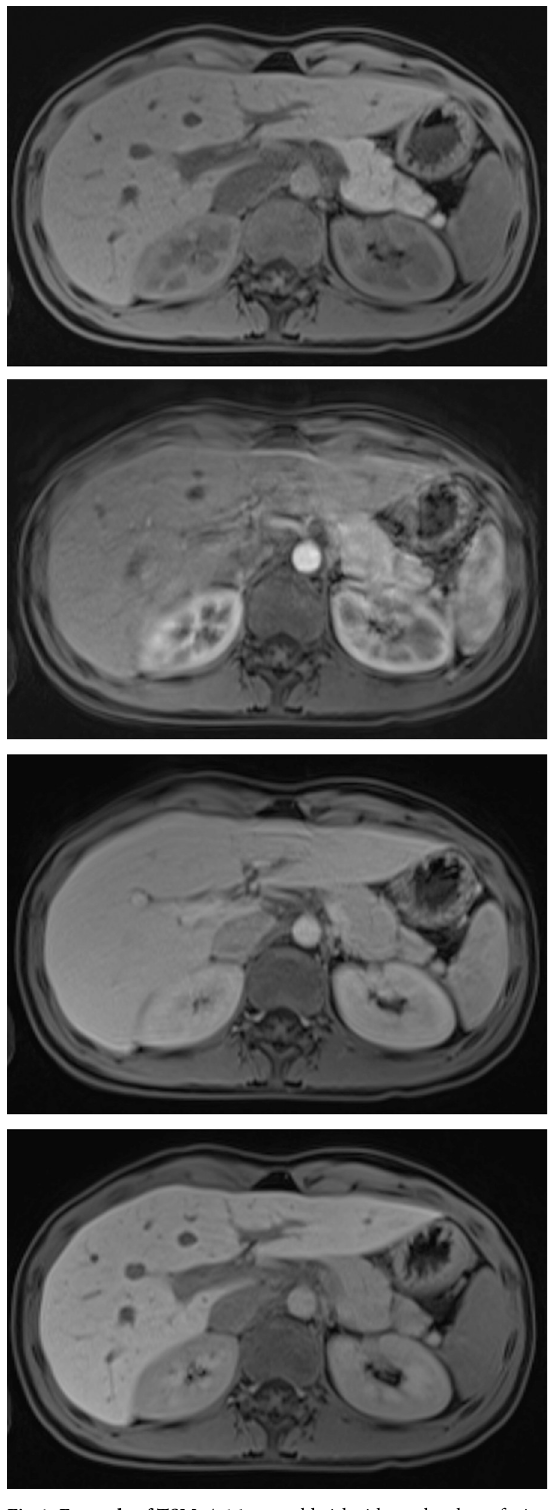
Fig 4. Example of TSM. A 16-year-old girl with an alveolar soft-tissue sarcoma of the left thigh who underwent Gd- EOB-DTPA-enhanced liver MRI for a suspected liver metastasis. There were no respiratory artifacts in the unenhanced phase (4A, IQ 3). TSM in the arterial phase (4B, IQ 1). There were still mild motion artifacts in the portal- venous phase (4C, IQ 2), and again, excellent IQ in the transitional phase (4D, IQ 3). https://doi.org/10.1371/journal.pone.0264069.g004 PLOS ONE | https://doi.org/10.1371/journal.pone.0264069 March 2,